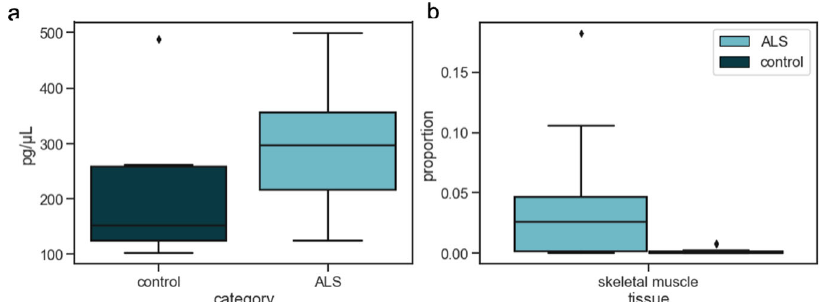
Fig. 8 CfDNA concentration and decomposition estimates for ALS patients and age-matched controls. a CfDNA concentrations for n = 28 independent cases and n = 25 independent controls and b CelFiE skeletal muscle estimates for n = 16 ALS patients (light blue) and n = 16 controls (dark blue) from both UCSF and University of Queensland. In both panels, the center line of the boxplot indicates the mean, the outer edges of the box indicate the upper and lower quartiles, and the whiskers indicate the maxima and minima of mean proportion of 0.42 ± 0.11 for ALS cases and 0.30 ± 0.19 for